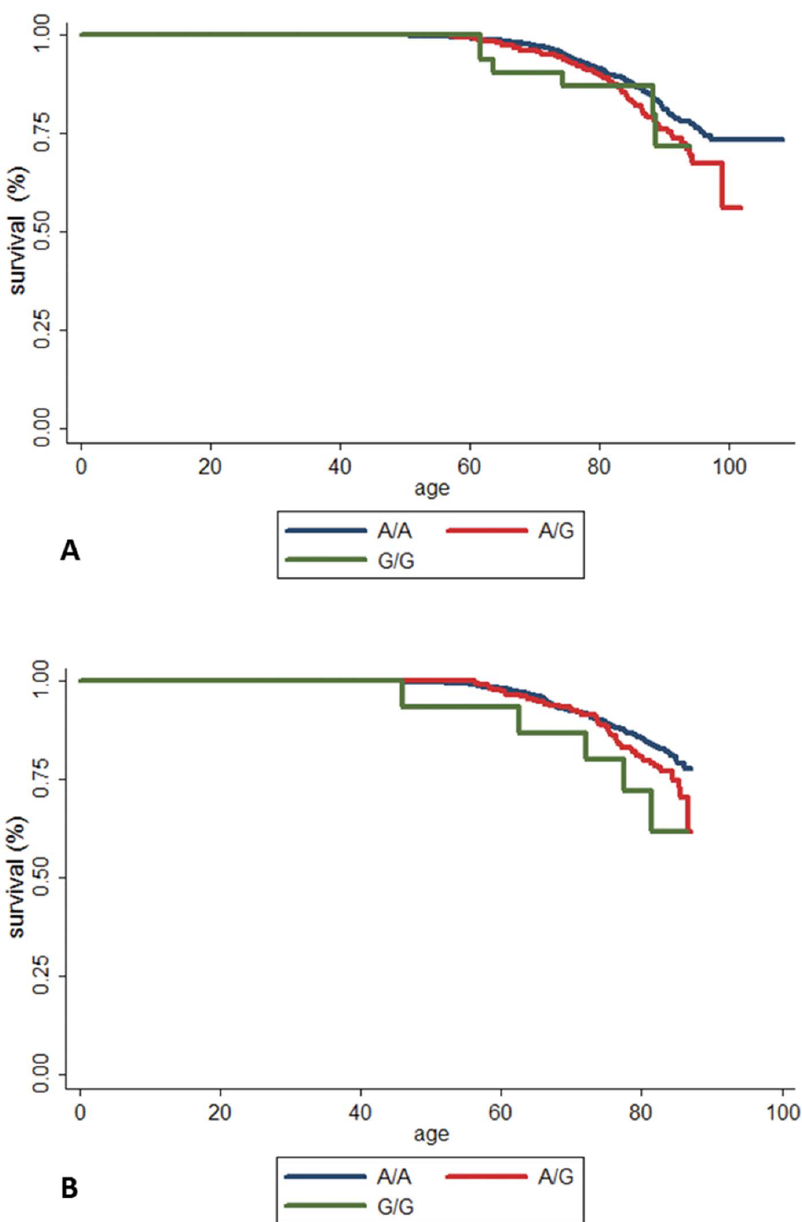
Figure 1. Kaplan-Meier survival function for rs4149313 and survival of MI in STR (A) and ULSAM (B). Survival function of MI for individuals having no (A/A; blue line); one (A/G; red line) or two (G/G; green line) risk alleles at ABCA1 rs4149313